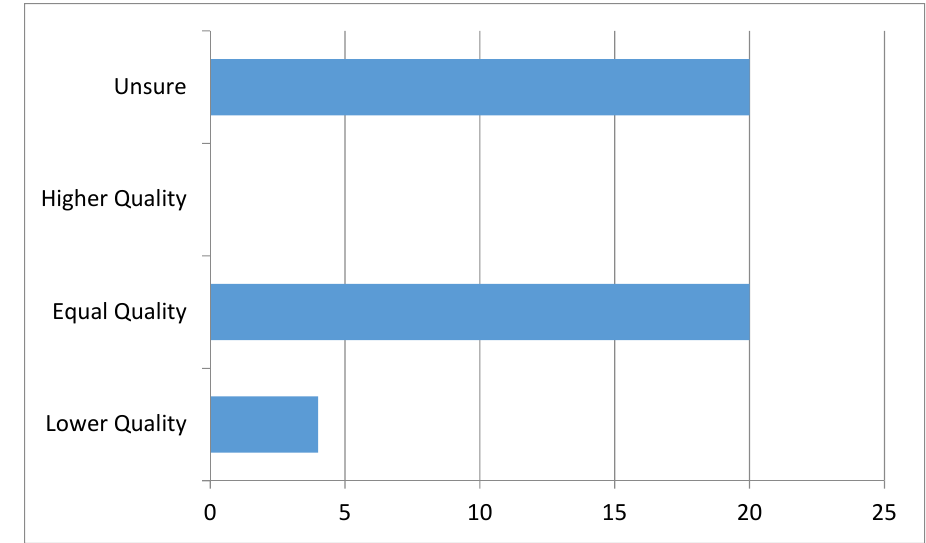
Figure 10. Perception of OA